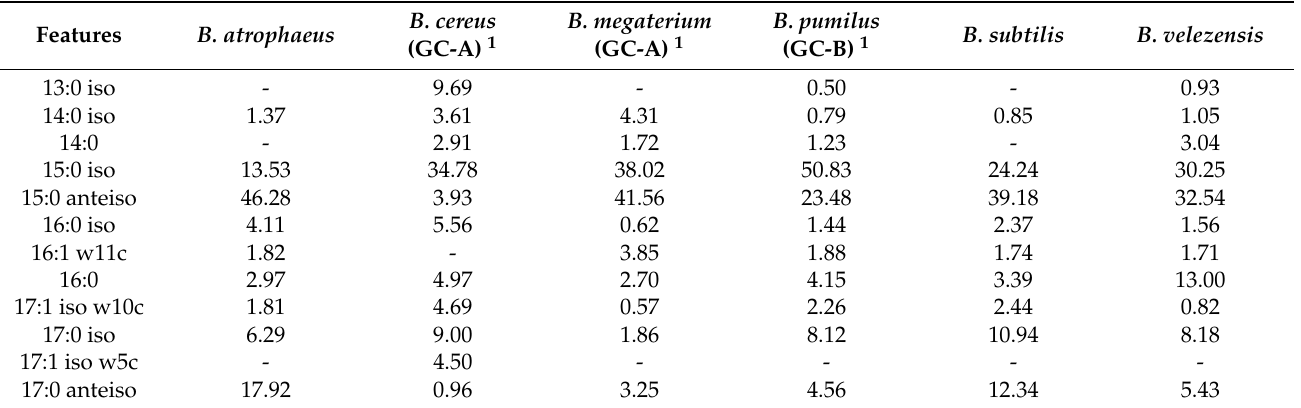
Table 2. Cellular fatty acid compositions (%) of the identified